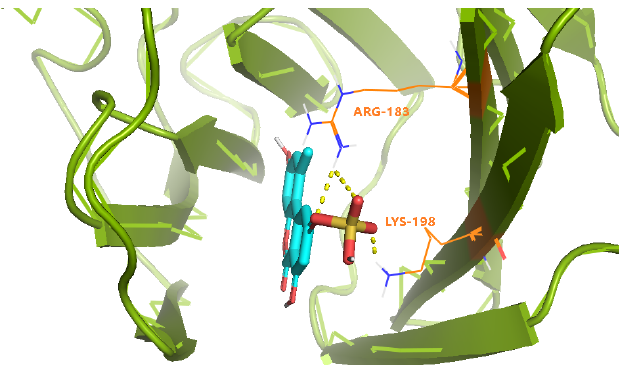
Fig. 7 Docking of CHEMBL483525 to spike. This experiment demonstrates that CHEMBL483525 may be a potential drug for COVID-19, which also indicates that FingerDTA can discover new drugs for unseen